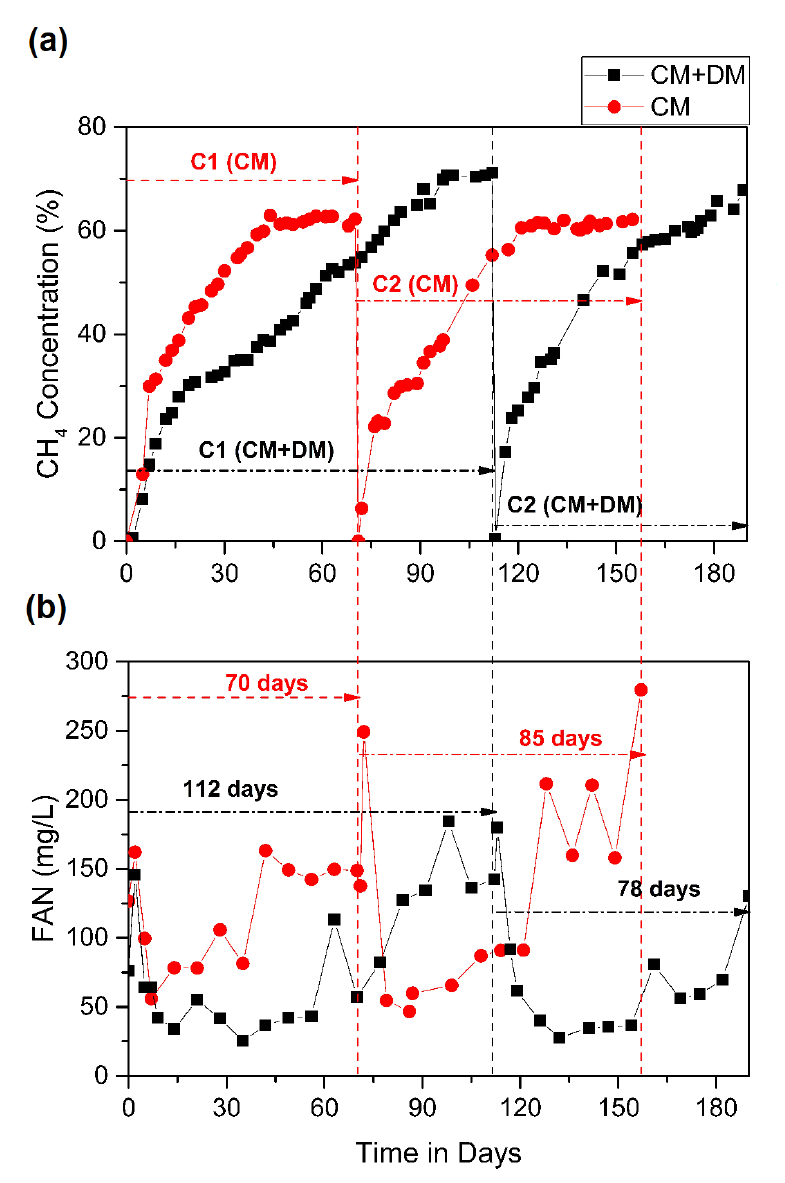
Figure 7. Comparative study of chicken manure (CM) mono-digestion and CM + dairy cow manure (DM) co-digestion: ( a ) Methane concentration profile; ( b ) FAN profile.